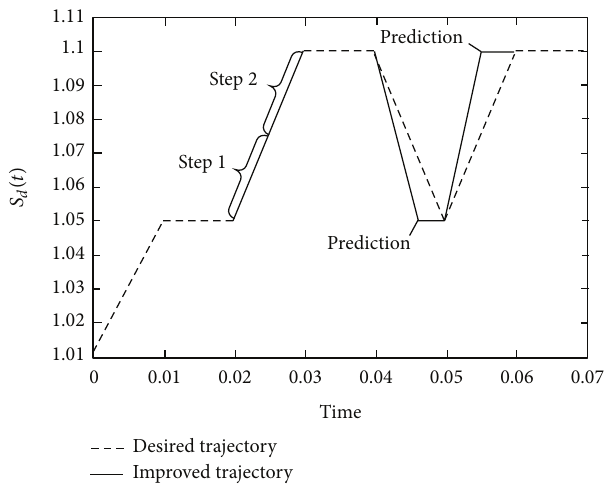
Figure 8: Improved control strategy with division and prediction. change as 𝑒 1 and 𝑒 2 , we have lim Δ (𝑒 /2Δ ) = −∞ , which leads to the lim Δ 2 2 2 →0